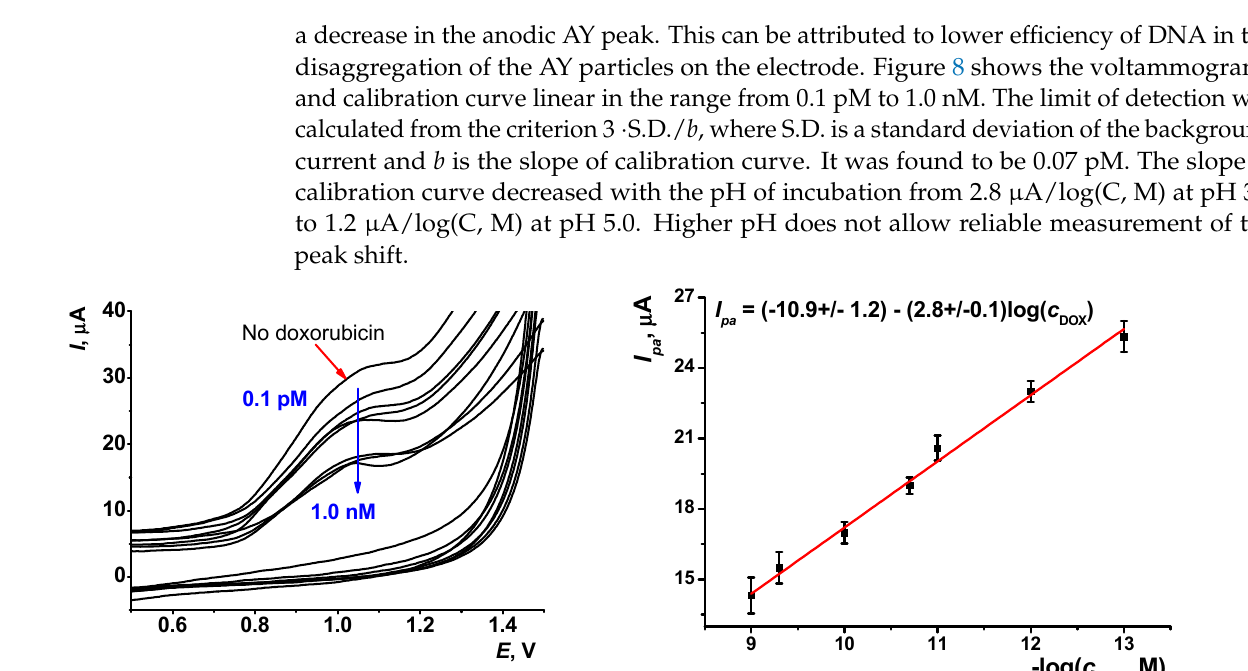
Table 2. Analytical characteristics of the determination of doxorubicin with electrochemical sensors and DNA sensors. Electrode Modifier/Electrode